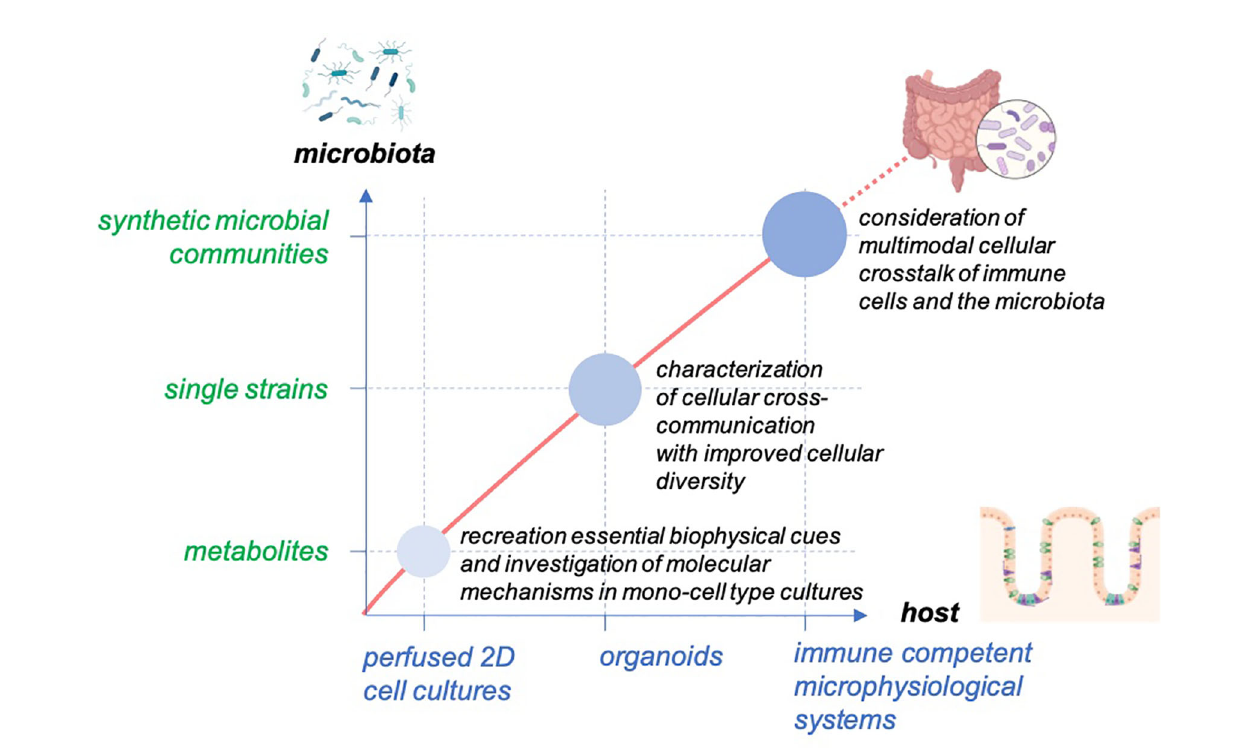
FIGURE 3 | Concept for studying host-microbiome interaction in gut-on-chip. The models enable the balancing of the cellular complexity of host tissue and provide the technical basis to facilitate the outgrowth of host cells to self-organized organoid structures with high cellular diversity. The systems allow the scaling of the biological complexity of the host and the microbiota to study the interaction of the host tissue with the microbiota from microbial metabolites to single microbial strains and diverse microbial